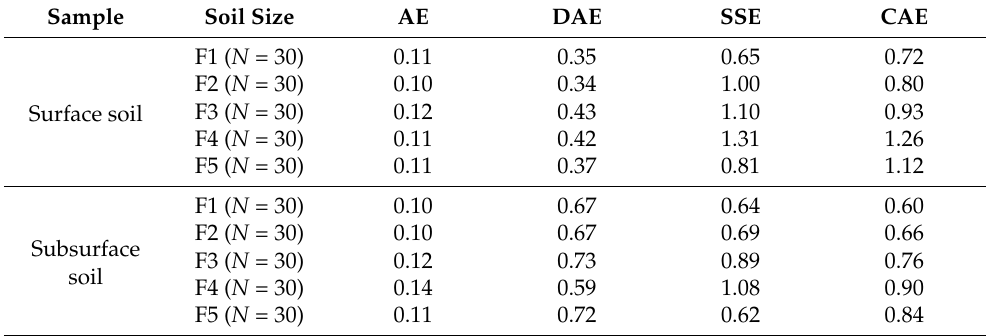
Table 3. Comparison of Hg content in different soil size after single extraction (average value, μg/kg ).